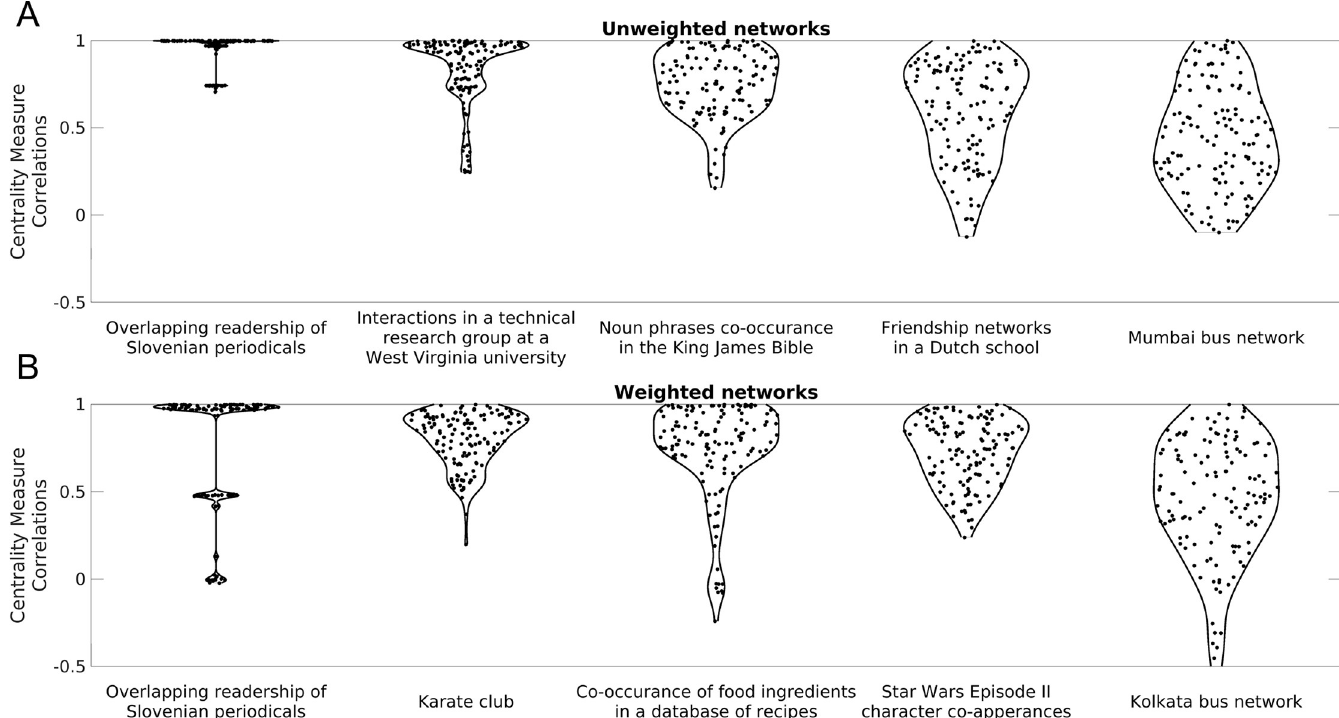
Fig 2. Distributions of Centrality Measure Correlations (CMCs) for example unweighted and weighted networks. Distributions of CMCs for every pair of centrality measures for five example unweighted (panel A ); and weighted networks (panel B ). Networks have been ordered from highest (left) to lowest (right) median CMC.